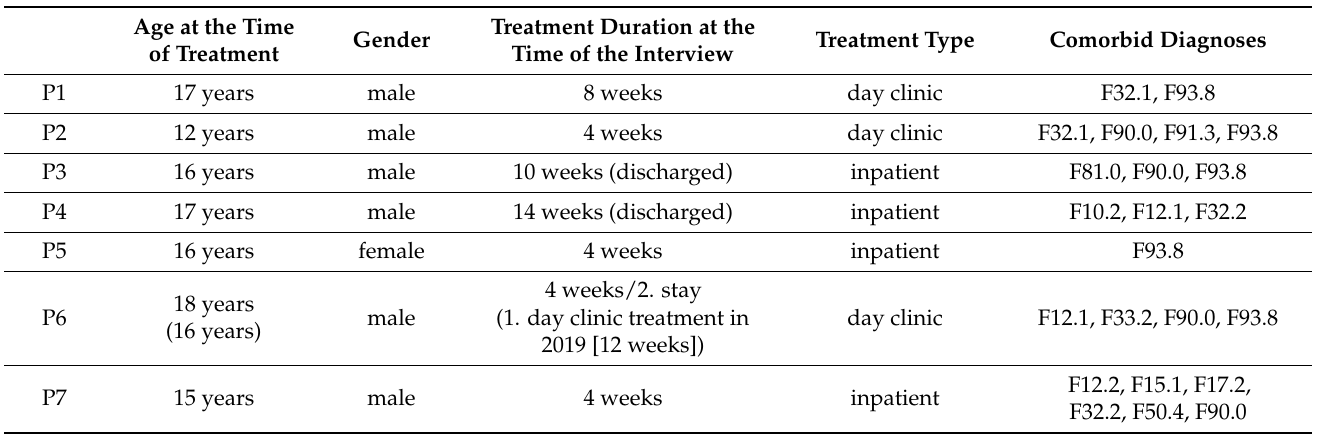
Table 1. Patients’ characteristics.